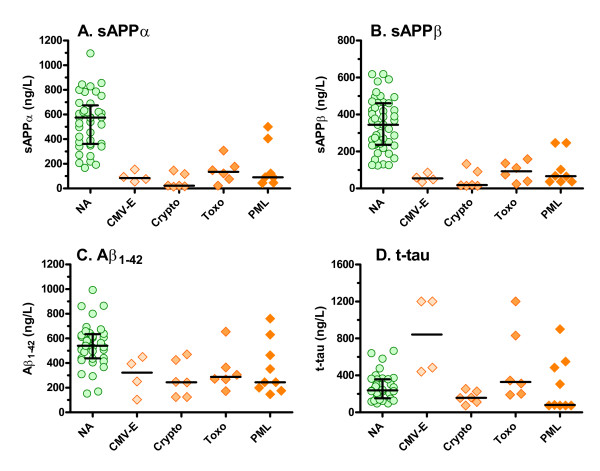
CSF biomarkers in opportunistic infections. The results for each of the biomarkers in the four infection subgroups are compared to the results of the HIV+ neuroasymptomatic subjects. The symbols show individual results while bars show medians and, for the neuroasymptomatics, the interquartile ranges. Abbreviations: NA, HIV+ neuroasymptomatics; CMV-E, CMV enecephalitis; Crypto, cryptococcal meningitis; Toxo, cerebral toxoplasmosis; PML, progressive multifocal leukoncephalopathy.